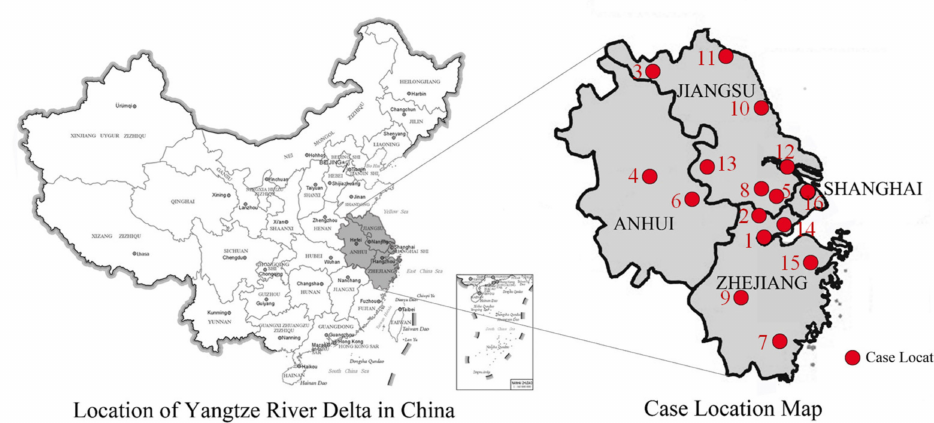
Figure 2. Distribution map of the case locations.